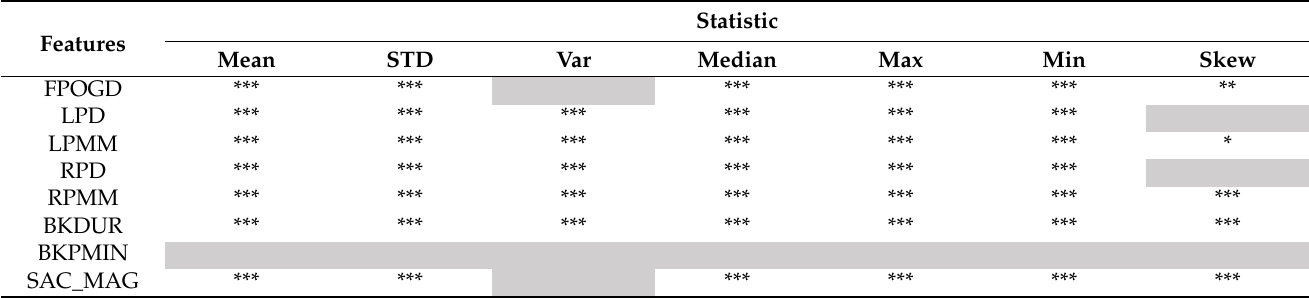
Table 2. Screened conventional eye-movement features using the ANOVA method from the eye- movement features.